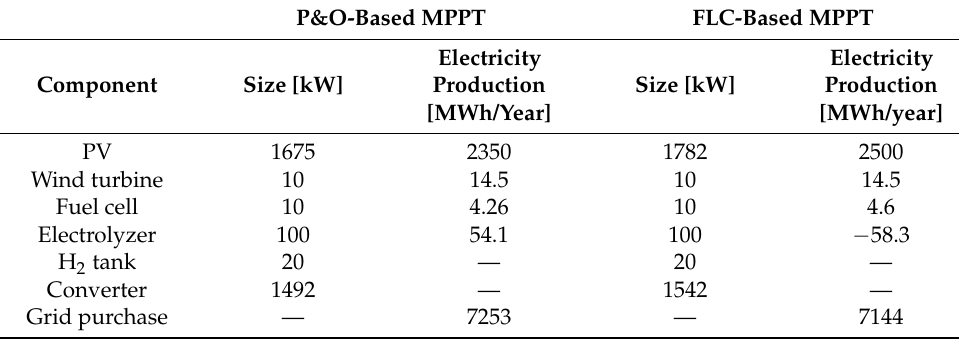
Table 10. Component capacity and electricity production of the proposed